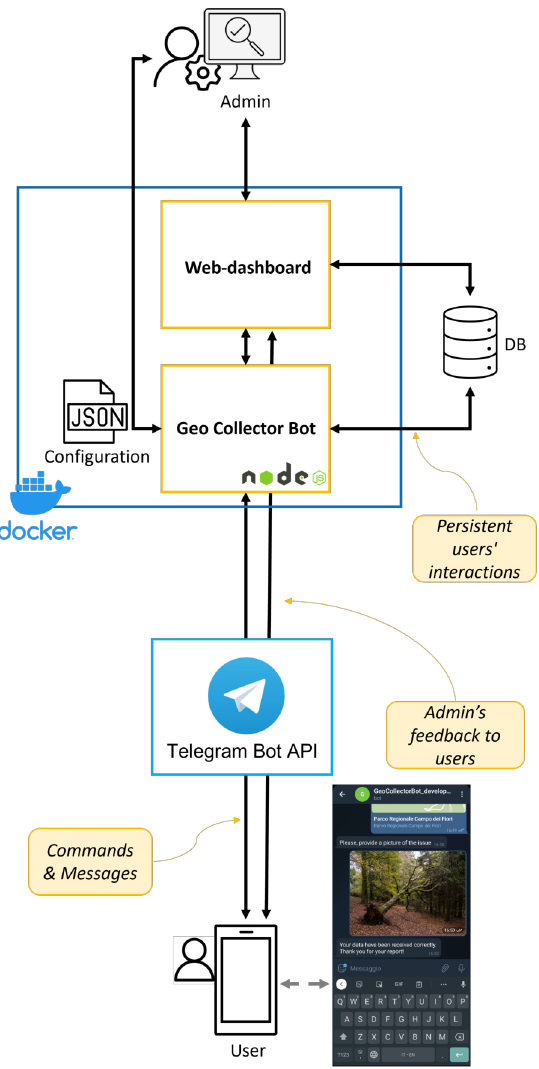
Figure 5. The Geo Collector Bot system architecture with a sample Telegram chat interface for data collection in the